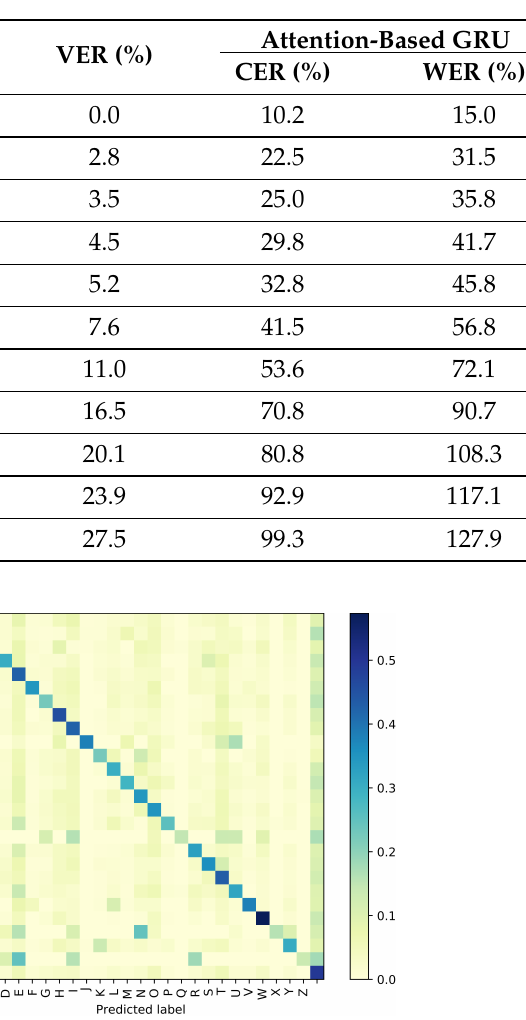
Table 8. Performance of viseme-to-word converters under varying noise levels on the LRS3 dataset.